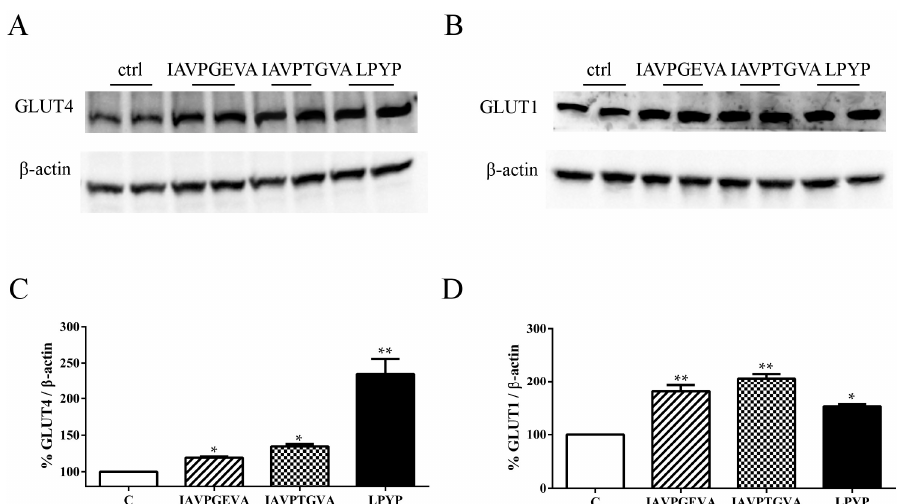
Figure 2. Effect of peptides on glucose transporter 4 (GLUT4) and glucose transporter 1 (GLUT1) protein levels. HepG2 cells (1.5 × 10 5 ) were treated with IAVPGEVA (500 μ M), IAVPTGVA (500 μ M) and LPYP (500 μ M) for 24 h. ( A , B ) Exemplary western blot analyses of GLUT4 and GLUT1 after treatment. Signals were detected using specific anti-GLUT4, anti-GLUT1 and anti- β -actin primary antibodies (loading untreated sample); ( C , D ) Quantitative analyses of immunoblots. GLUT4 and GLUT1 band intensities were quantified by ChemiDoc (BioRad, Hercules, CA, USA) and normalized using β -actin signals. Bars represent averages of duplicate samples ± SEM of seven independent experiments. * p < 0.05, ** p < 0.001 versus untreated sample. C, untreated sample.